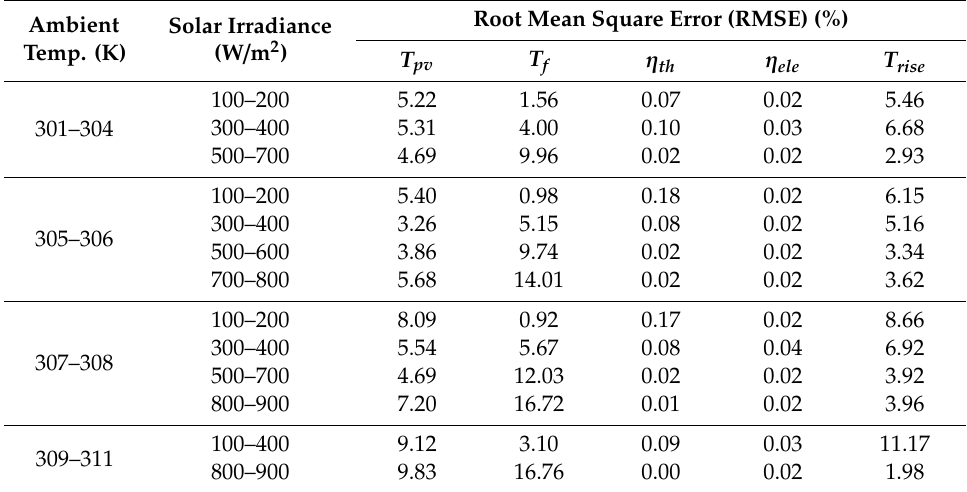
Table 2. Values of coe ffi cients and ambient conditions used in the